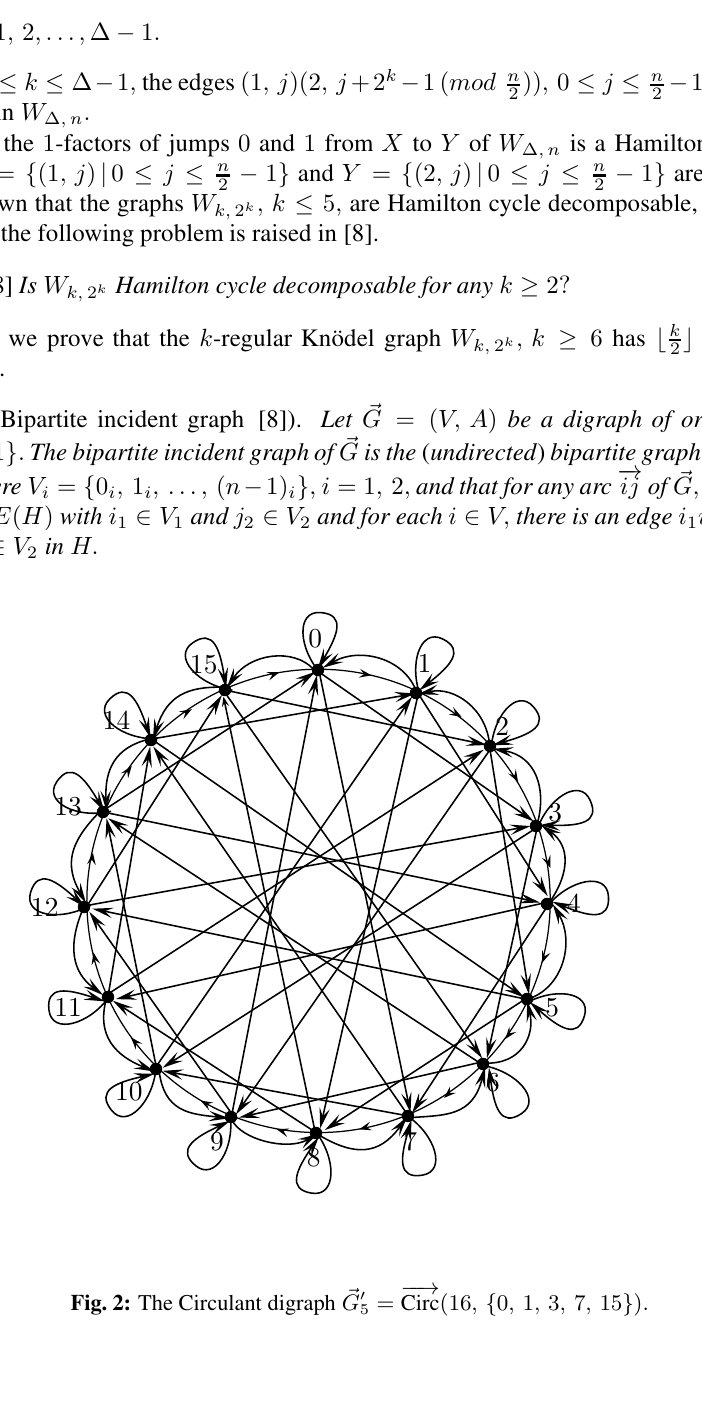
Fig. 2: The Circulant digraph ~G ′ 5 =